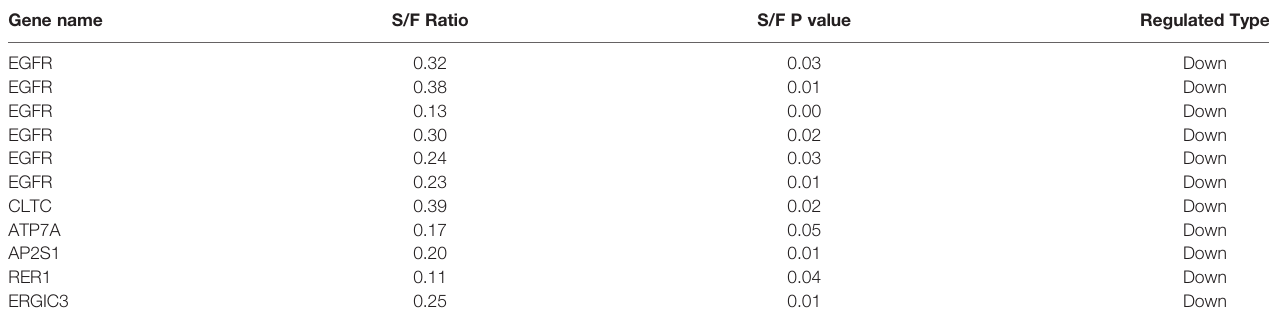
TABLE 1 | Ubiquitinated proteins enriched in protein secretion pathway by